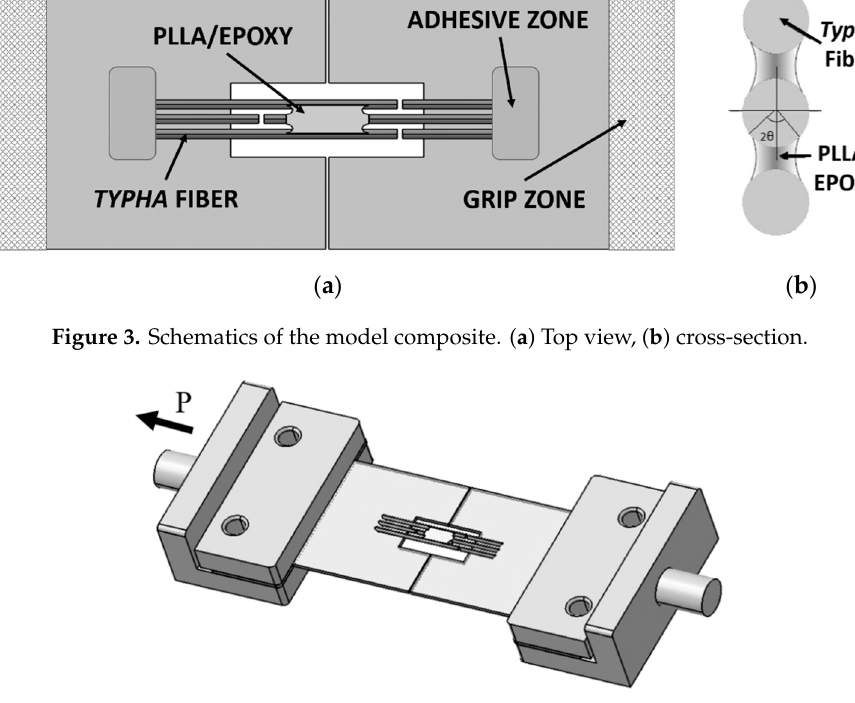
Figure 4. Schematics of the double shear method of the three-fiber model composite.